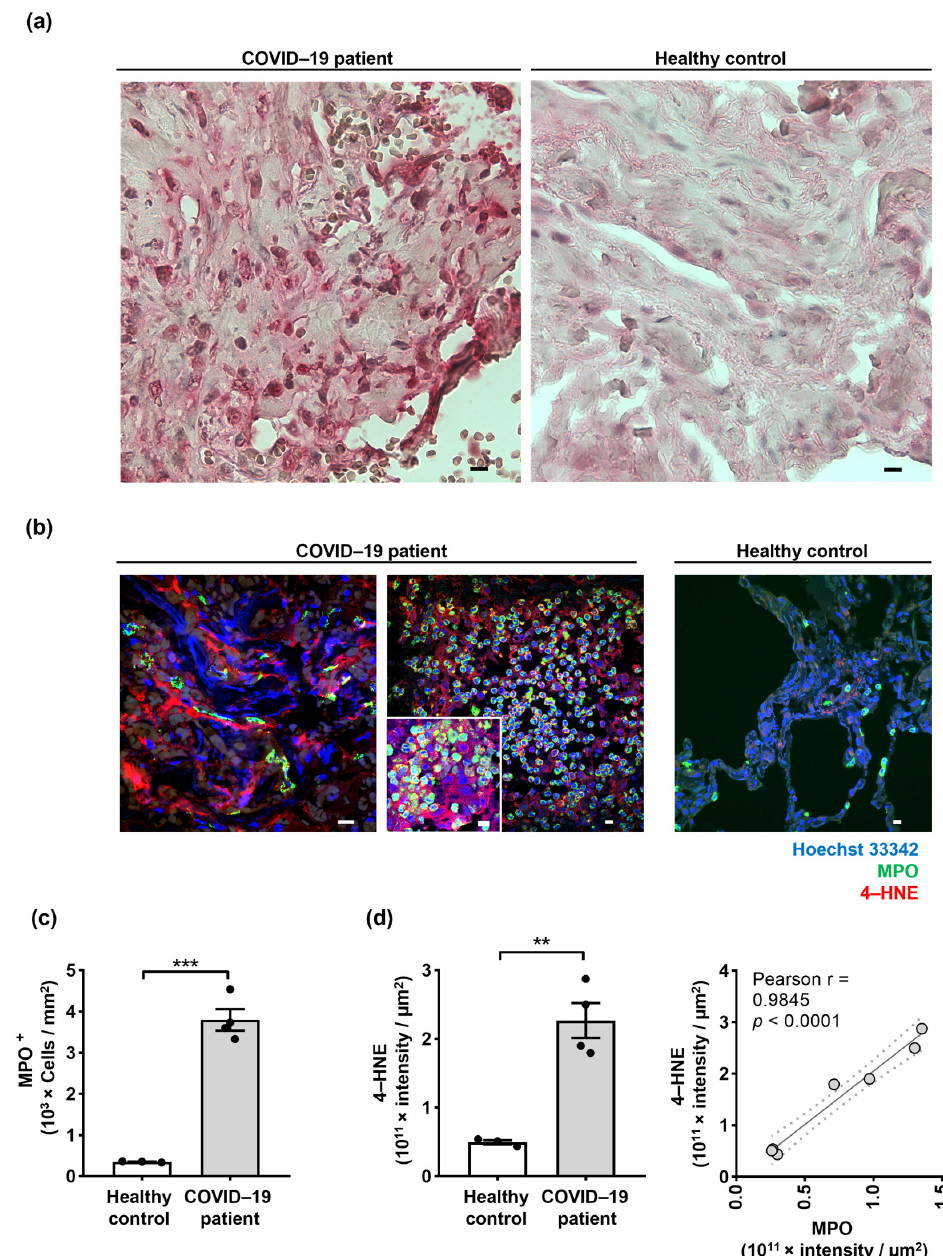
Figure 4. Increased lipid oxidation occurs in the lungs of COVID–19 patients and its possible involvement in NET formation. ( a ) Paraformaldehyde-fixed lung tissues of COVID–19 patients ( n = 4) and control donors ( n = 3) were subjected to 4–HNE antibodies by immunohistochemistry. Scale bars, 20 μ m. Representative original data are shown. ( b ) Confocal microscopy analysis of NETs in COVID–19 patients ( n = 4) and control donors ( n = 3) depicted by anti-MPO antibody (green), anti-4–HNE antibody (red), and counterstained with Hoechst 33342 (blue). Scale bars, 10 μ m. Representative original data are shown. ( c ) Quantification of neutrophils in COVID–19 patients ( n = 4) and control donors ( n = 3) using an automatic digital slide scanner (Panoramic MIDI II, 3DHistech, Budapest, Hungary) is shown as cells/mm 2 . ( d ) Quantified fluorescence intensity sums of 4–HNE and MPO in COVID–19 patients ( n = 4) and control donors ( n = 3) were performed for each tissue section using Imaris software as intensity sum/ μ m 2 . The right panel shows the correlation between the intensity of 4–HNE and MPO in the lung tissues ( n = 7). Values are means ± SEM. Single data are presented in scatter dot plots. ** p < 0.01; *** p < 0.001.